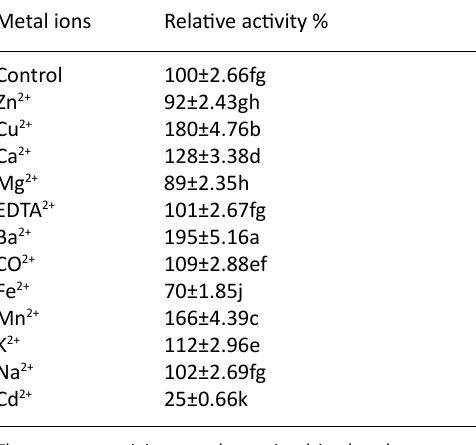
Table 2. Laccase production by S. mutabilis A17 using solid natural substrates